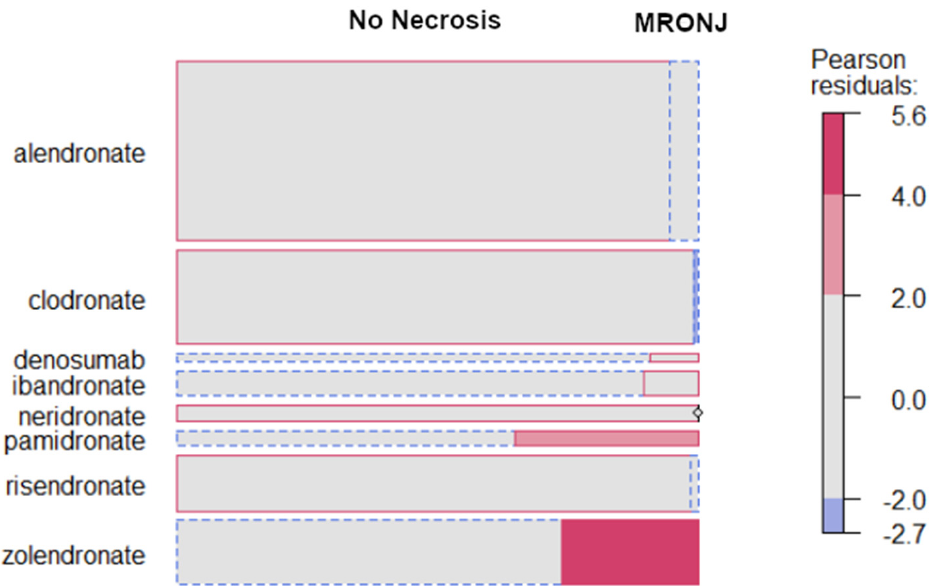
Figure 5. Pearson residuals express difference from mean (expected) in sigma units. Its clinical meaning is a shortcoming of expected cases in patients treated with clodronate compared to the other ARDs.